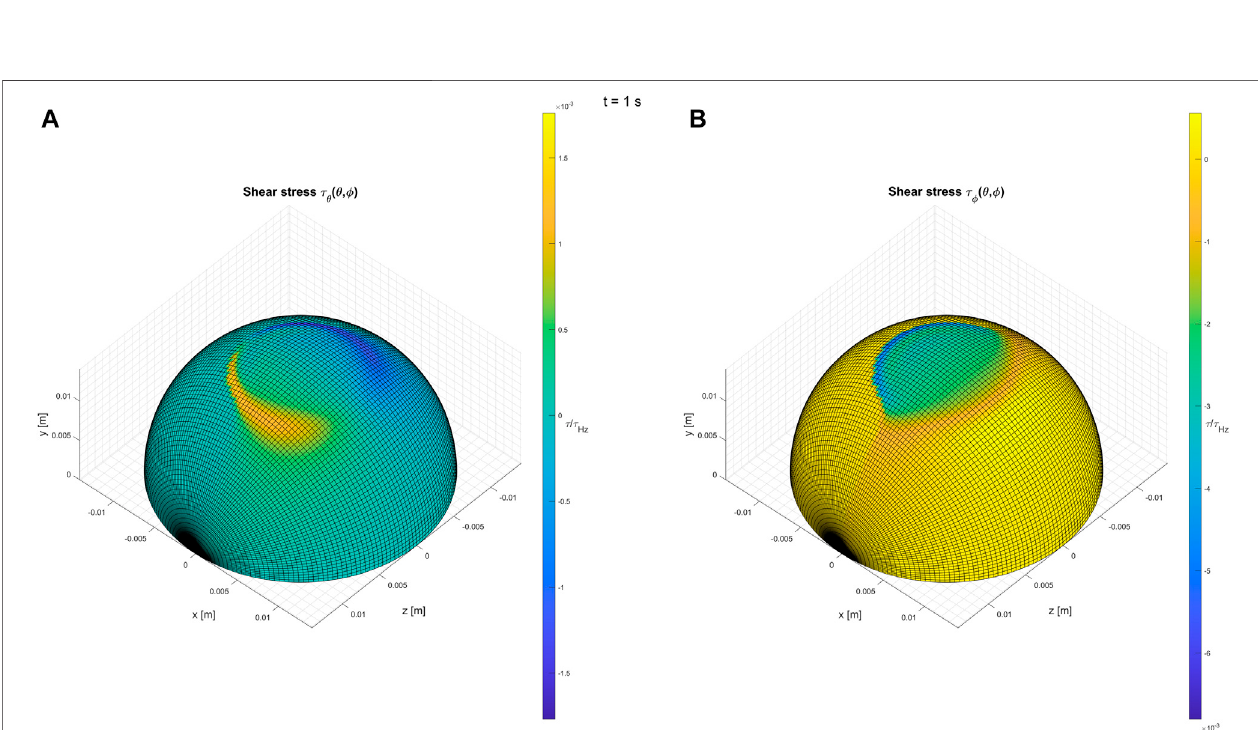
FIGURE 9 | Shear stress fi elds over the socket spherical domain along θ (A) and φ (B) directions.